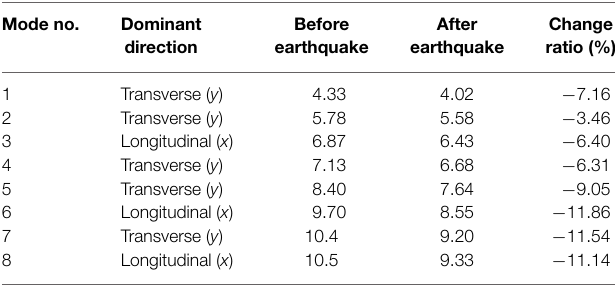
TABLE 2 | Natural frequencies and damping ratio before and after the 2015 Gorkha earthquake: damping ratio of the first mode. Parameter Direction Before After Change earthquake (%) earthquake (%) ratio (%) First mode Transverse ( y ) damping ratio